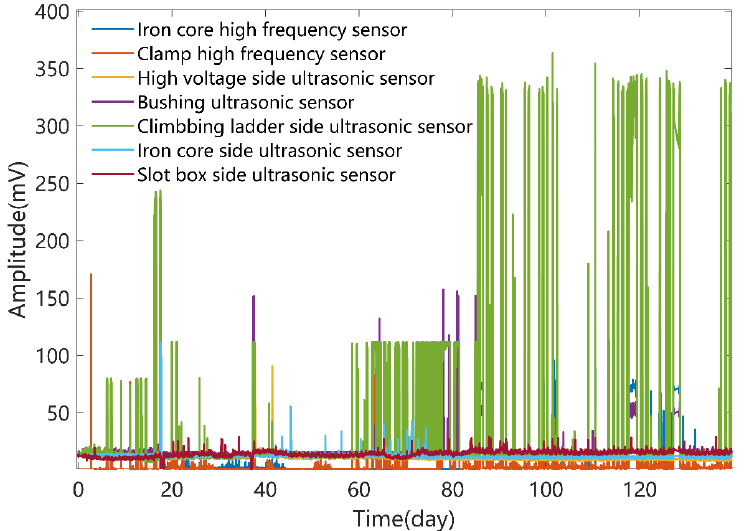
Figure 4. Acquisition of pulse current of reactor and measurement data of ultrasonic sensor in the past six months by envelope detection method.